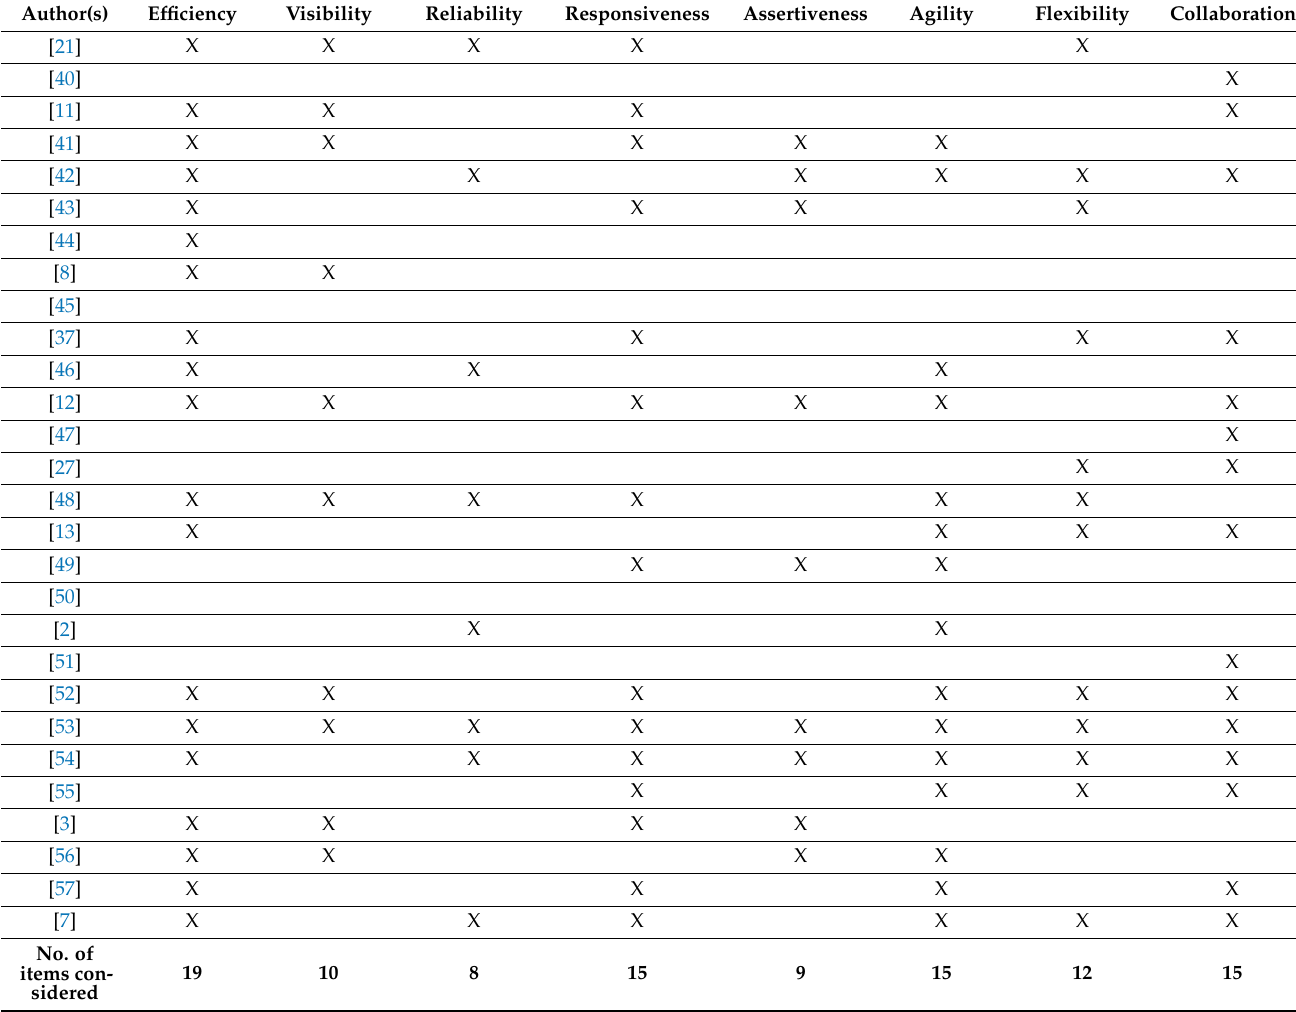
Table 5. Sub-categories for performance requirements.